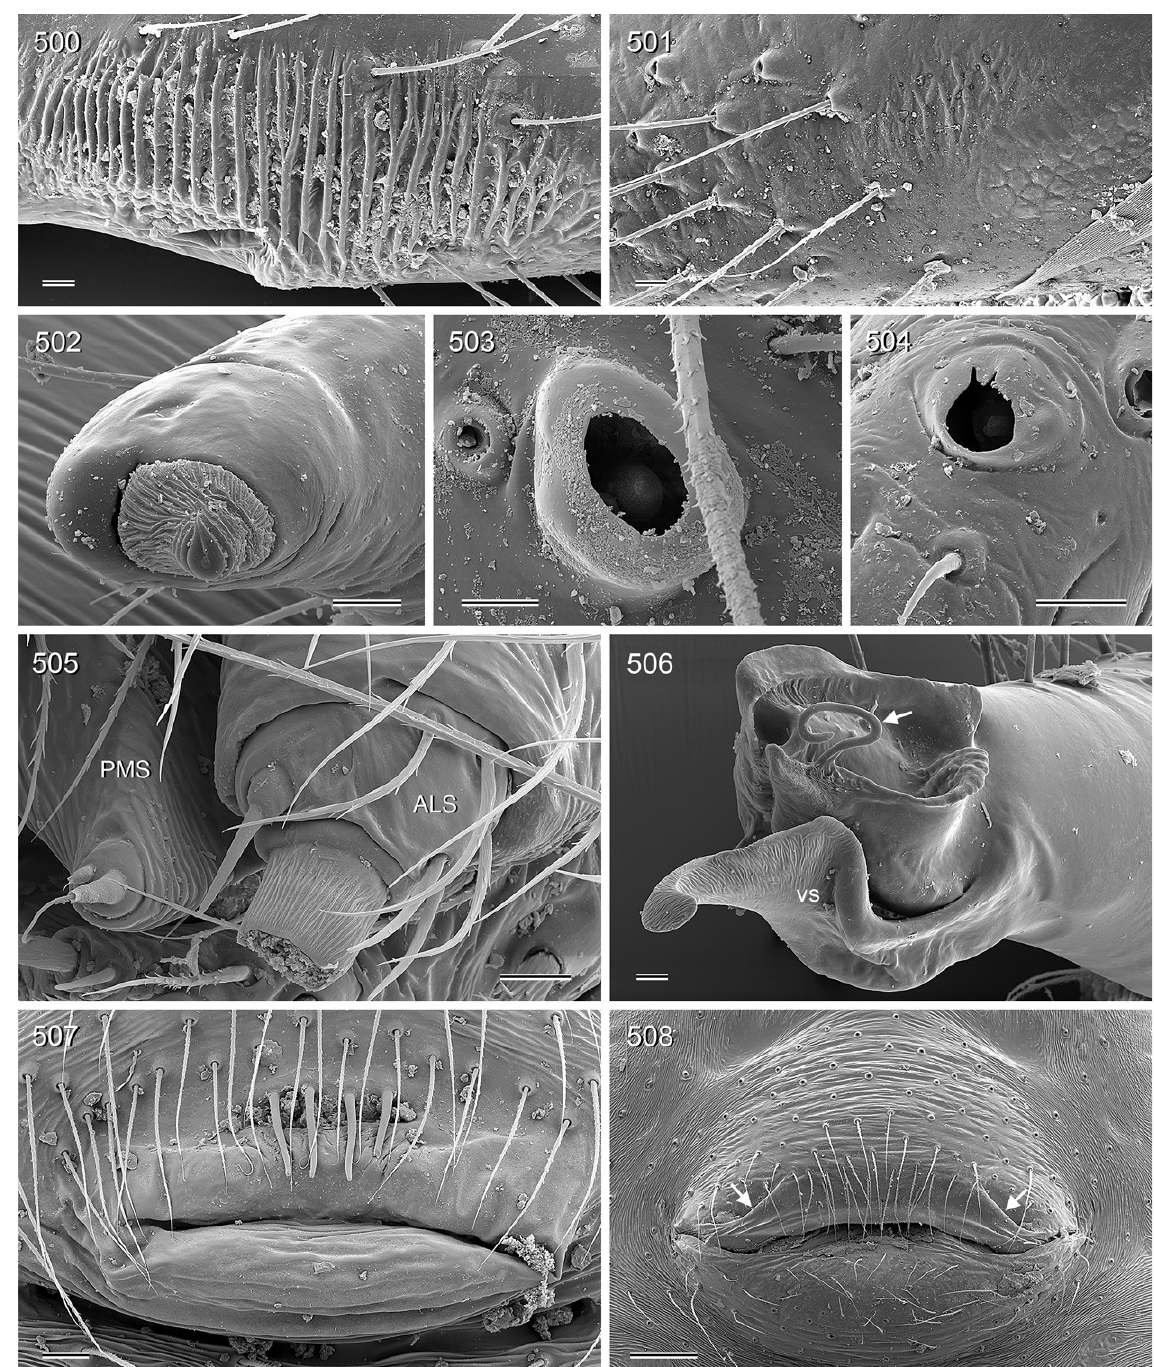
Figs 500–508. Crossopriza moqal sp. nov.; male and female from Oman, Moqal Cave (ZFMK Ar 22421, Ar 22422). 500–501 . Male and female cheliceral stridulatory files. 502 . Tip of male cheliceral apophysis. 503–504 . Male and female palpal tarsal organs. 505 . Male spinnerets. 506 . Left procursus tip, retrolateral-distal view; arrow: hair-like process. 507 . Male gonopore. 508 . Epigynum; arrows: pockets. Abbreviation: vs = ventral sclerite. Scale bars: 500–506 = 10 µm; 507 = 20 µm; 508 = 100